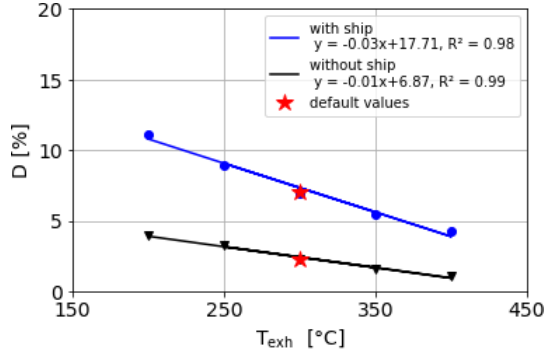
Figure 9. Dependence of the downward dispersion D on different exhaust temperatures T exh with and without the obstacle effect.